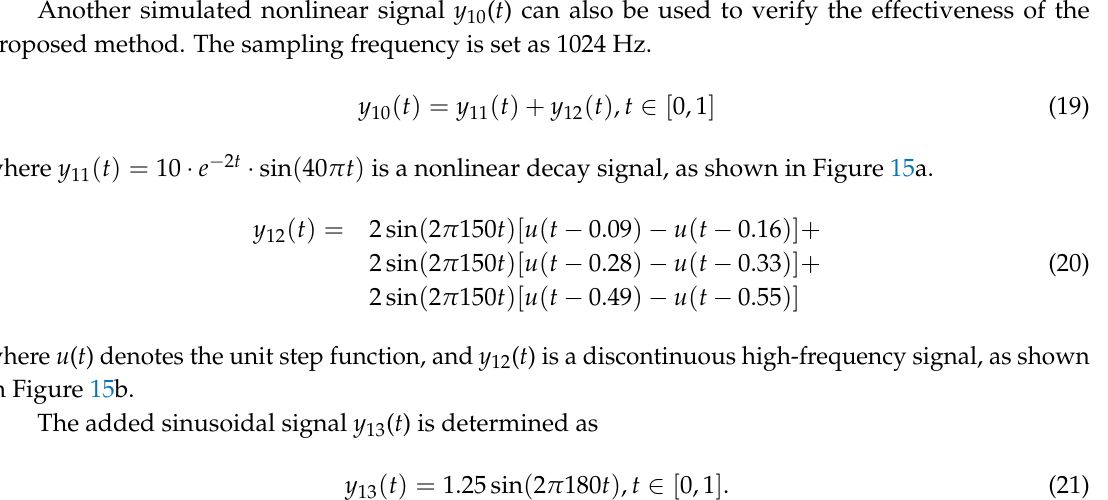
Figure 15. The simulated signals. ( a ) The simulated signal y 11 ( t ); ( b ) the simulated signal y 12 ( t ).